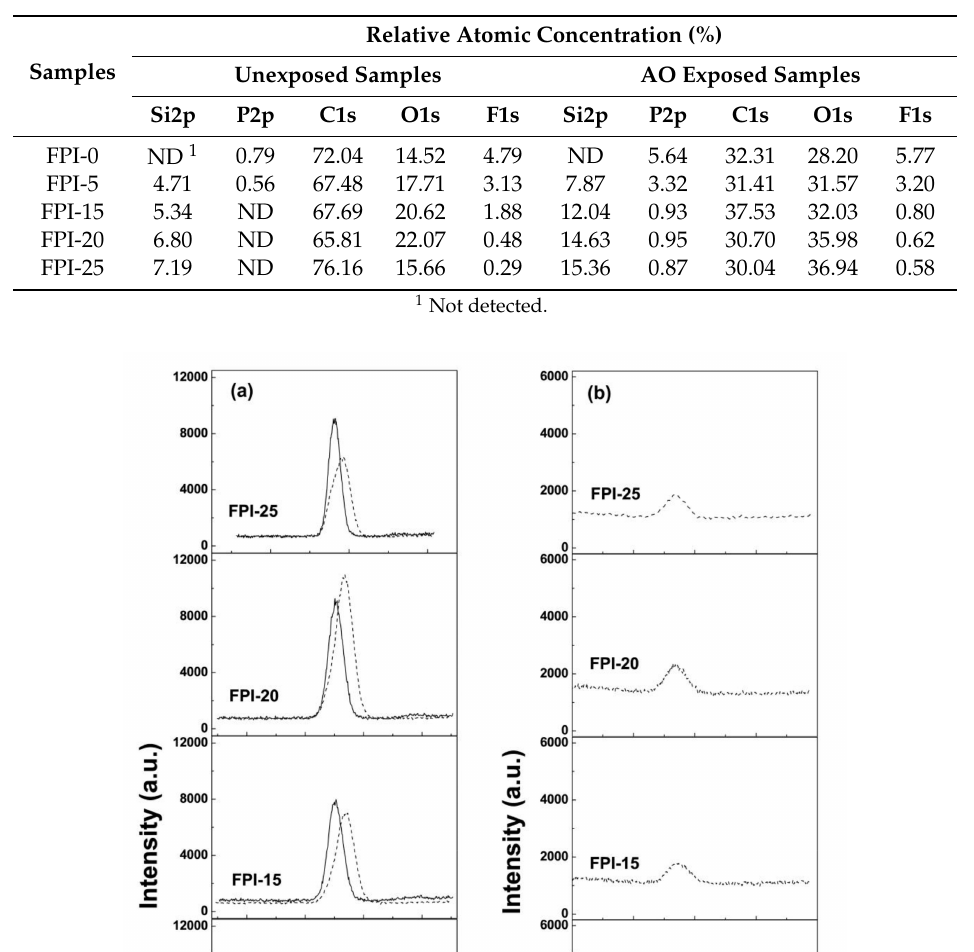
Table 4. XPS results for the unexposed and exposed PI films.